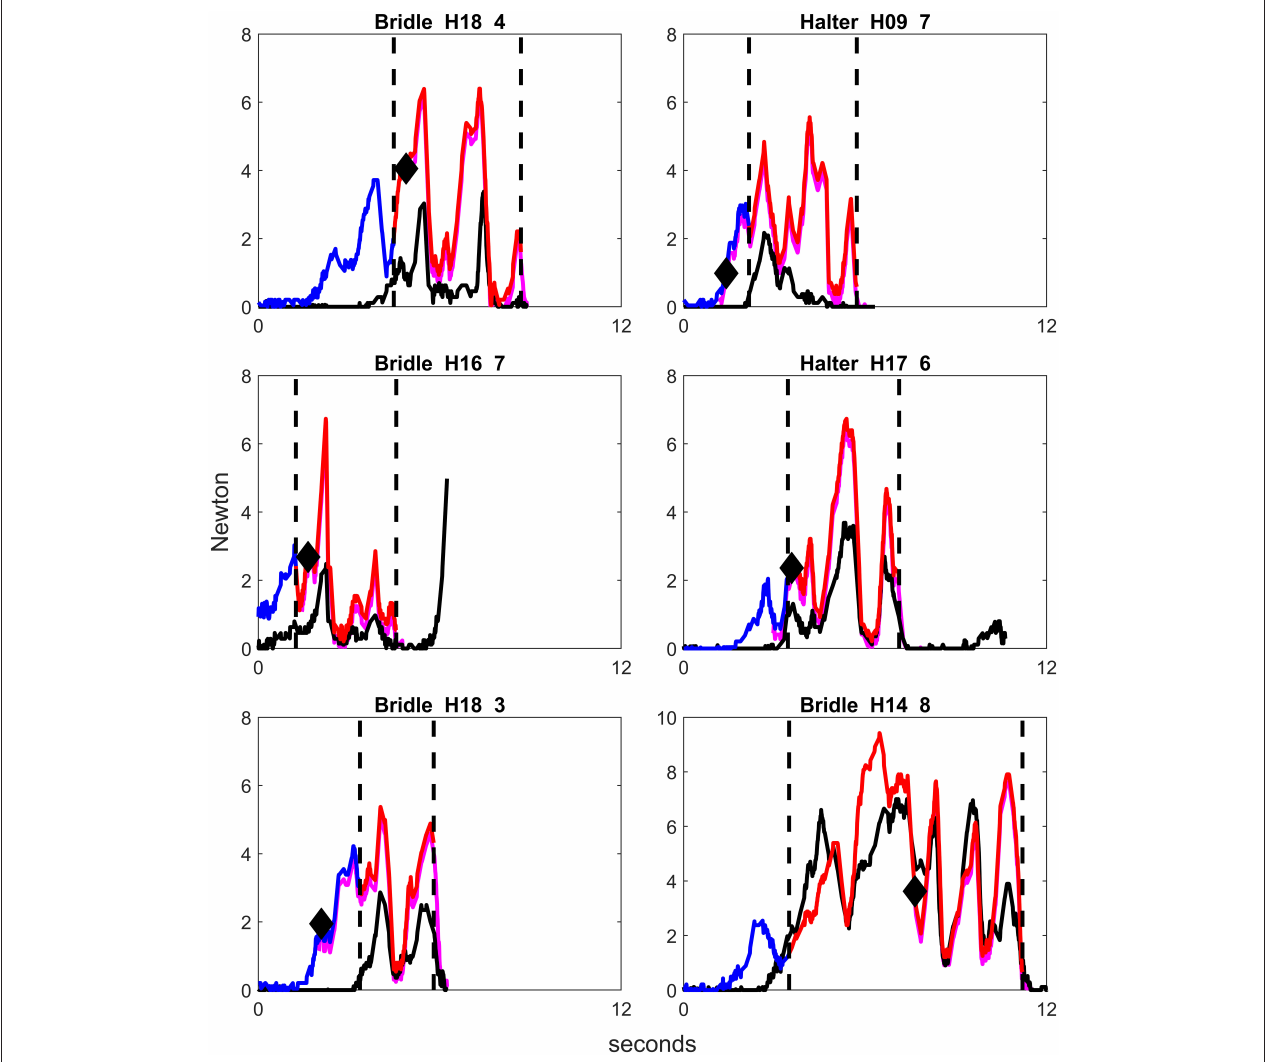
FIGURE 5 | Examples of graphs of rein tension signals using bridle or halter in different horses, from repetitions where the handler applied rein tension for three steps back and with no other behavioral response than backing. Blue color on the rein tension curve illustrates the phase picking up the reins, red color illustrates the rein tension signal, and purple illustrates the horse stepping back. Only the right rein is colored. The first vertical dotted line demonstrates the onset of the rein tension signal and the second vertical dotted line displays the lowering of the handler’s hands, i.e., release of the rein tension signal. The black diamond signifies the onset of backing. The repeated decreases in magnitude of rein tension after the onset of backing demonstrate the release of rein tension accompanying each step back. H = Horse, first number is horse number, second number is repetition number. Note that the y-axis differs slightly between graphs.